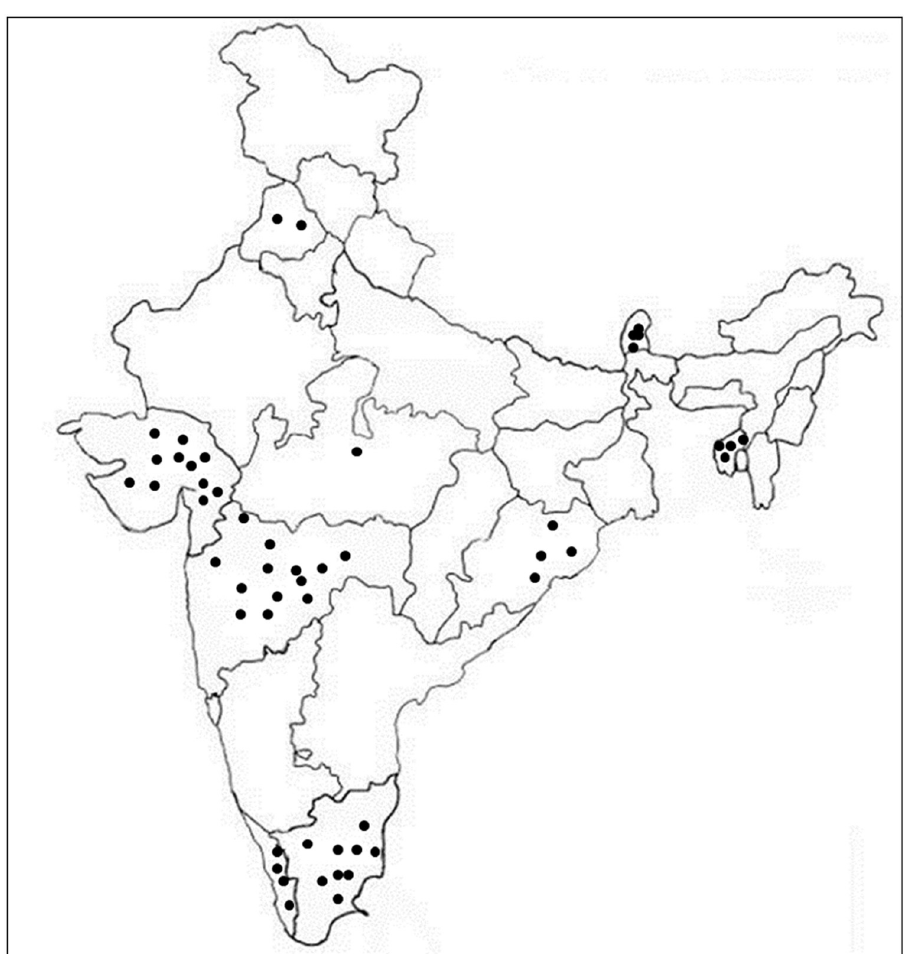
Fig 5. Population structure of Indian landraces based on 28 marker for blast resistance